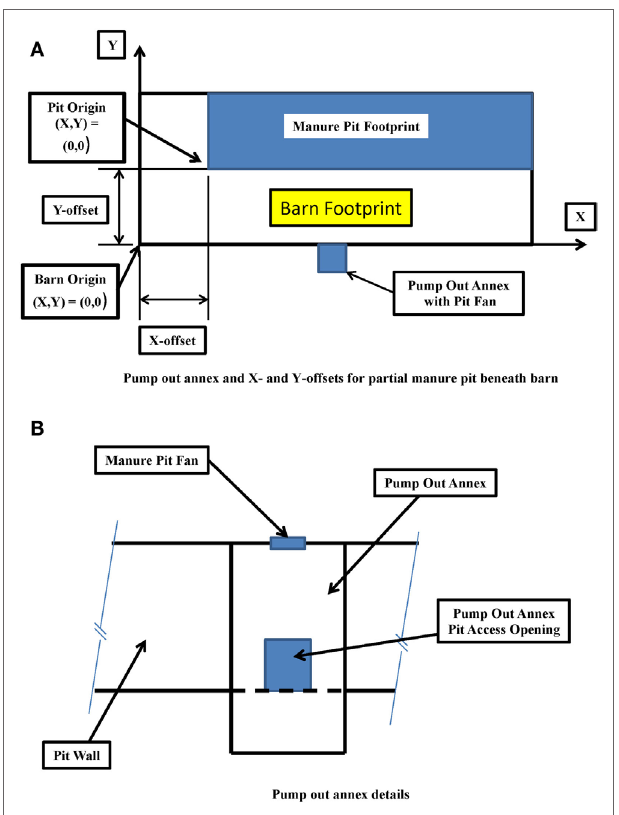
FIgURe 6 | Definition sketches for (A) typical manure pit pump-out annex and manure pit offsets and (B) pump-out annex details